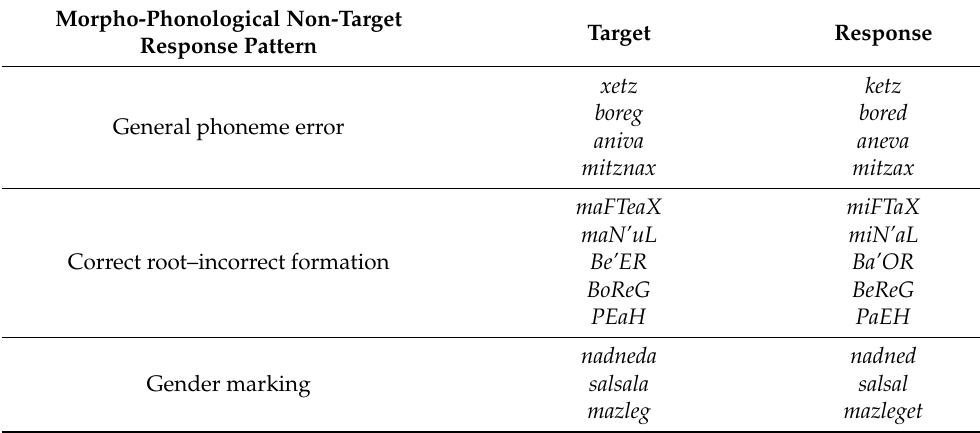
Table 3. Some Examples of Morpho-Phonological Non-target